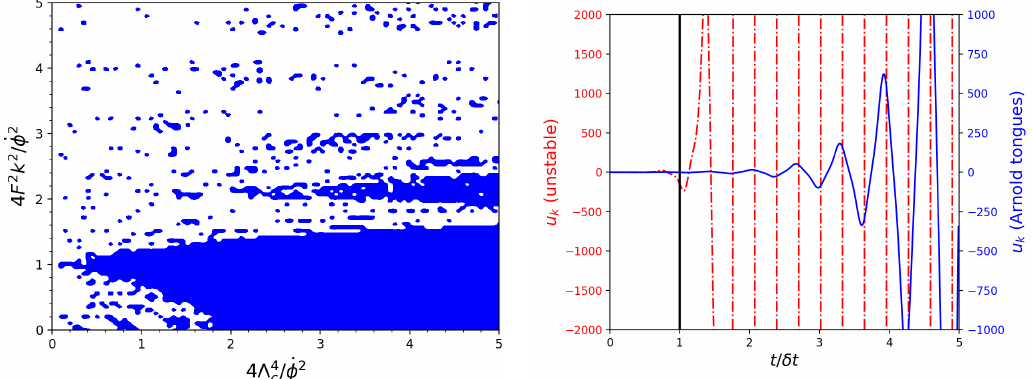
Figure 5 . The left plot shows the instability band with Arnold tongues. The right plot shows the solution where the parameters come from the unstable band (red) and from the Arnold tongues region (blue). The black line is the time scale where the particle production starts, δt ∼ φ 0 / ˙ φ ∼ 10 GeV − 1 . The parameters from the unstable band are chosen from the main tongue with 4 F 2 k 2 4Λ 4 c = 4 . 0 . The Arnold tongue solution is given by 4 F 2 k 2 ˙ φ 2